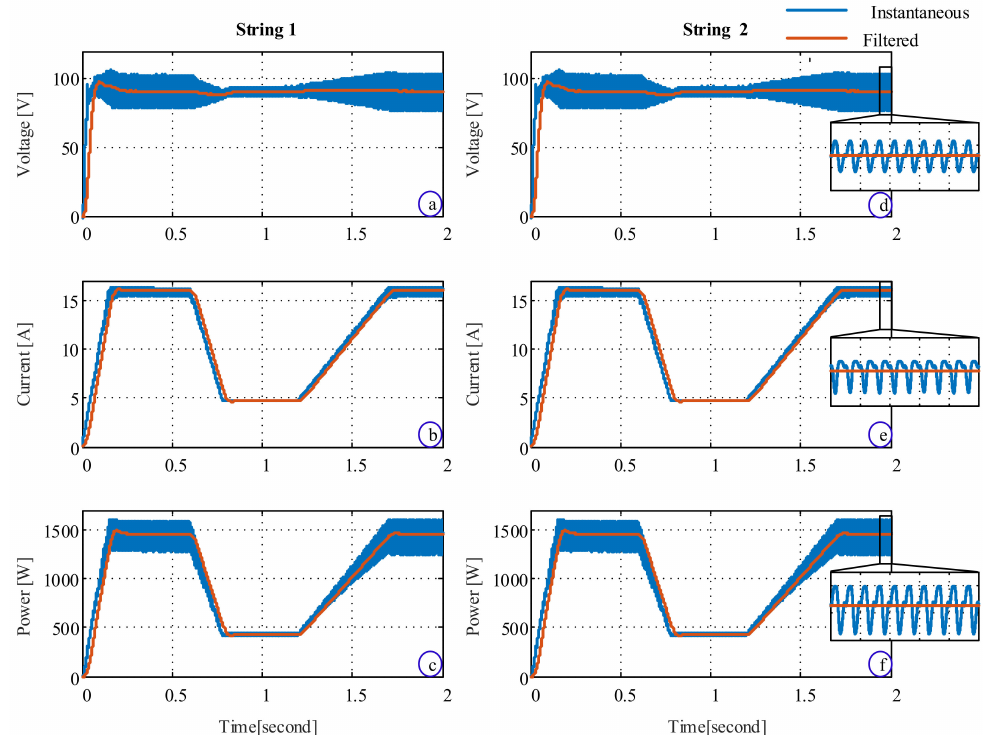
Figure 11. Output of PV strings: ( a ) voltage of string 1, V pv 1 , ( b ) current of string 1, i pv 1 , ( c ) power of string 1, P pv1 = V pv 1 × i pv 1 , ( d ) voltage of string 2, V pv 2 , ( e ) current of string 2, i pv 2 , ( f ) power of string 2, P pv 2 = V pv 2 × i pv 2